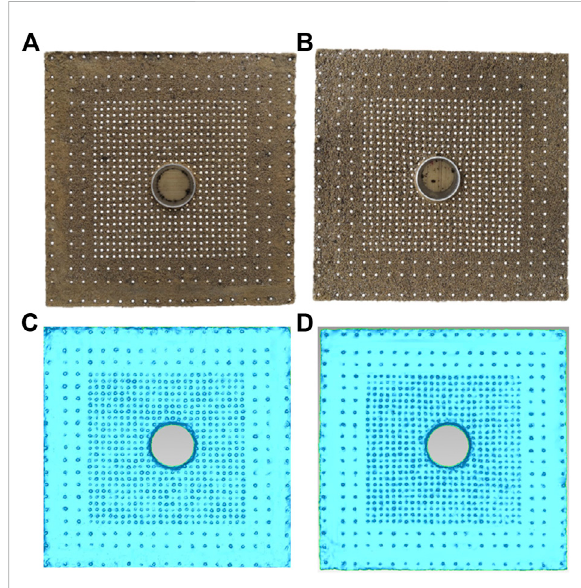
FIGURE 6 Excavation time step.